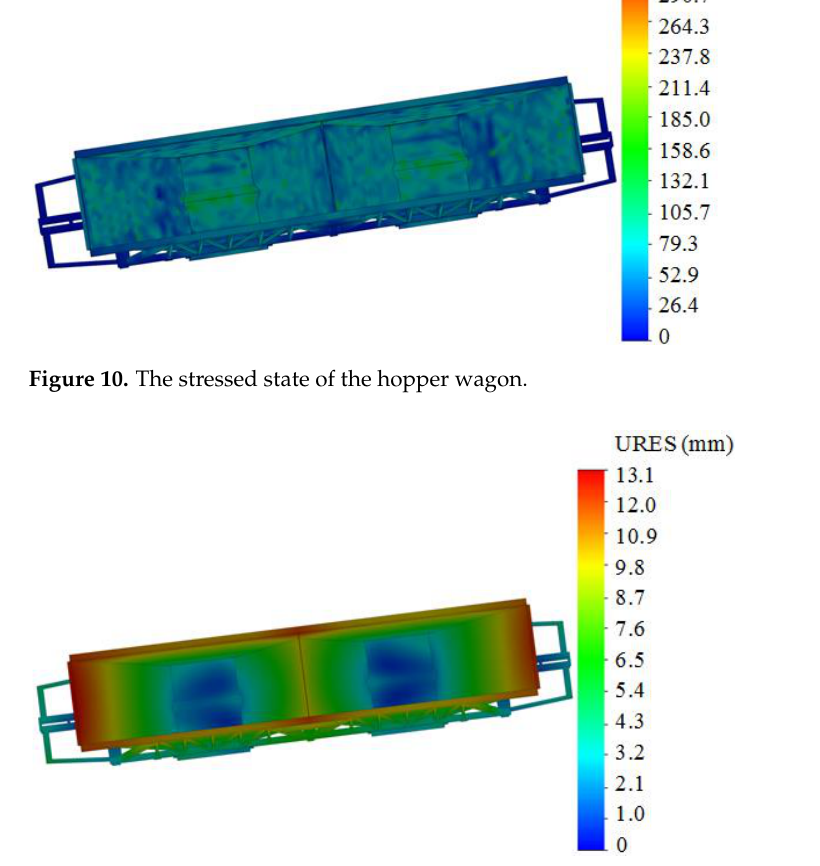
Figure 11. Displacements in the nodes of the hopper wagon.